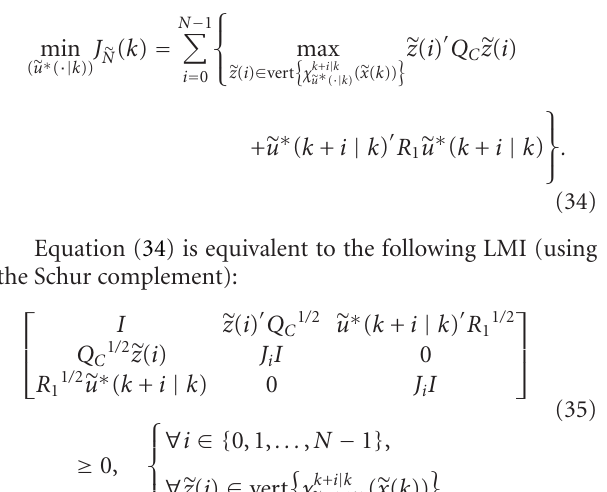
Figure 3: Outputs of Tracking RMPC with di ff erent weighting values μ .